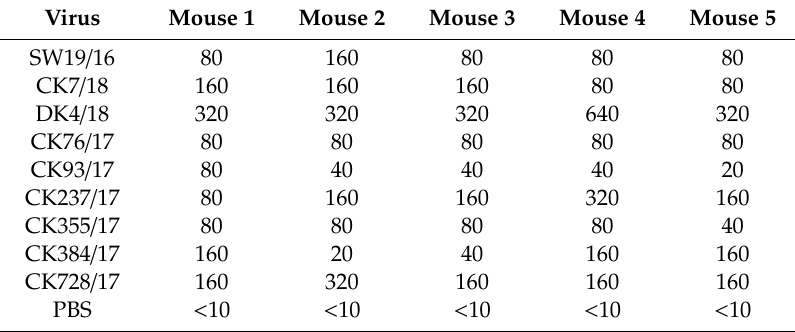
Table 3. HI titers of sera collected from mice inoculated with influenza viruses.